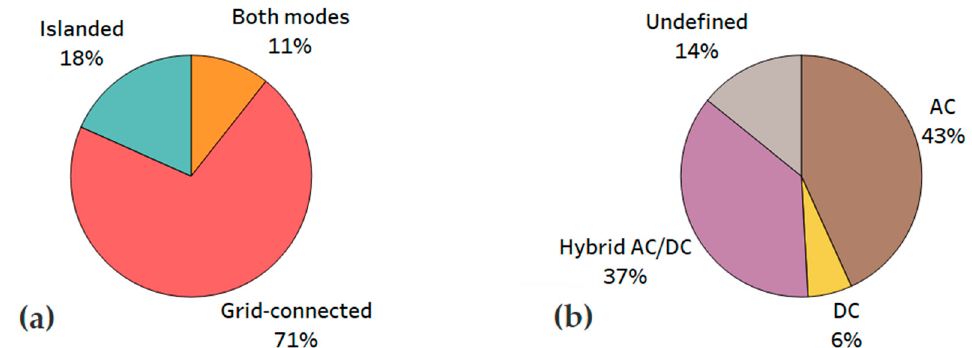
Figure 2. ( a ) Percentage of articles that consider each mode of operation of the microgrid. ( b ) Percentage of articles that consider each microgrid power type. Note: in many articles, the power type is not explicitly mentioned, but assumed from the microgrid topology.